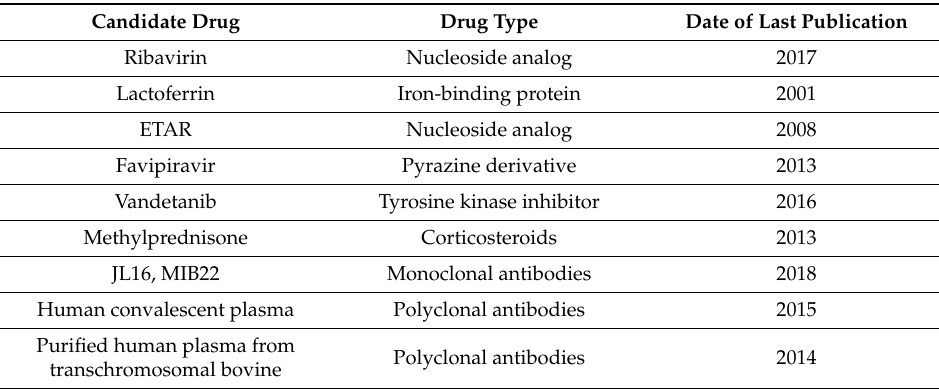
Table 2. Hantavirus candidate